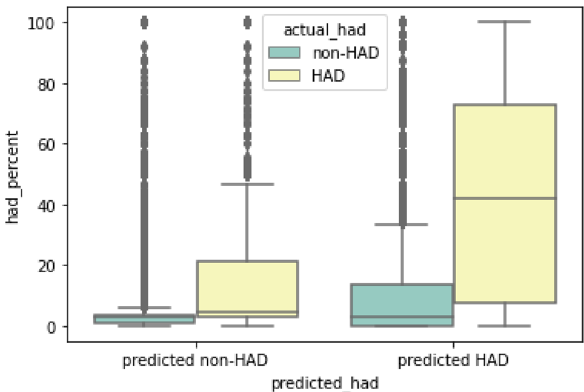
Figure 8. HAD binary classification result in OPD data set.